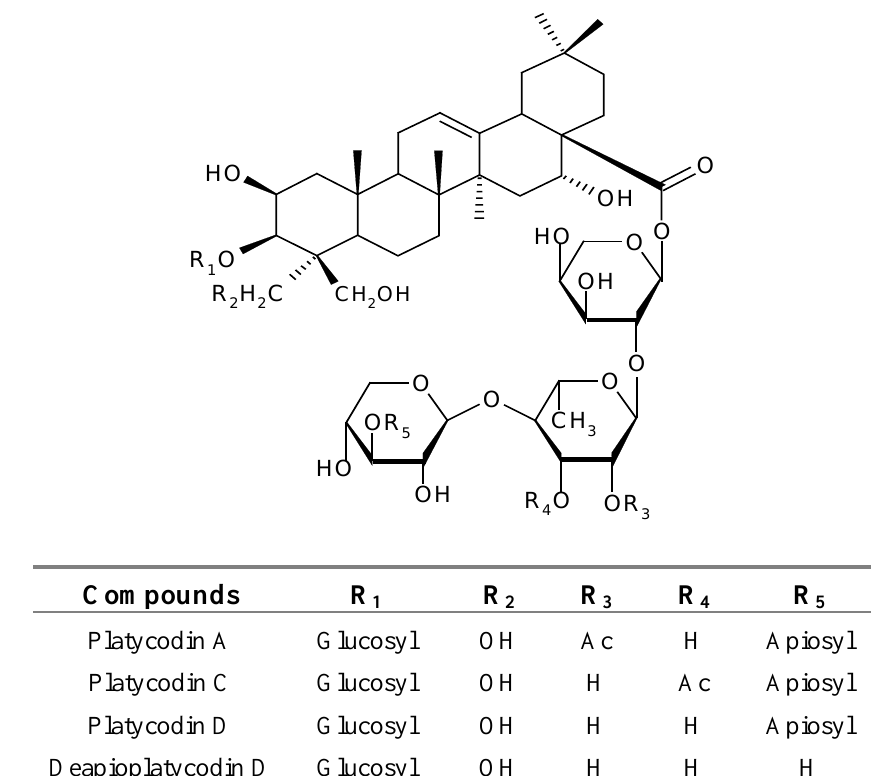
Figure 1. Triterpene saponins isolated from P. radix